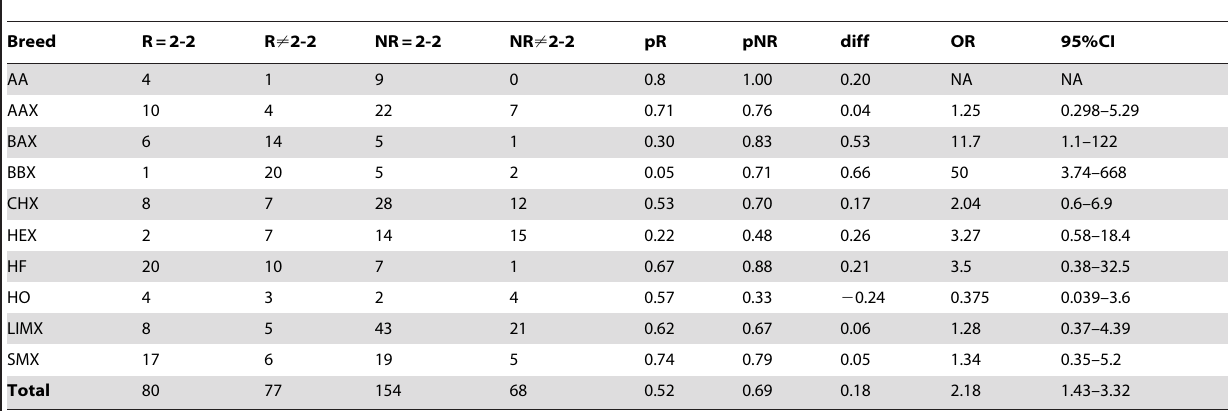
Table 4. Distribution of 2-2 genotypes at locus INRA111 among reactors and non-reactors drawn from 10 breeds of cattle.